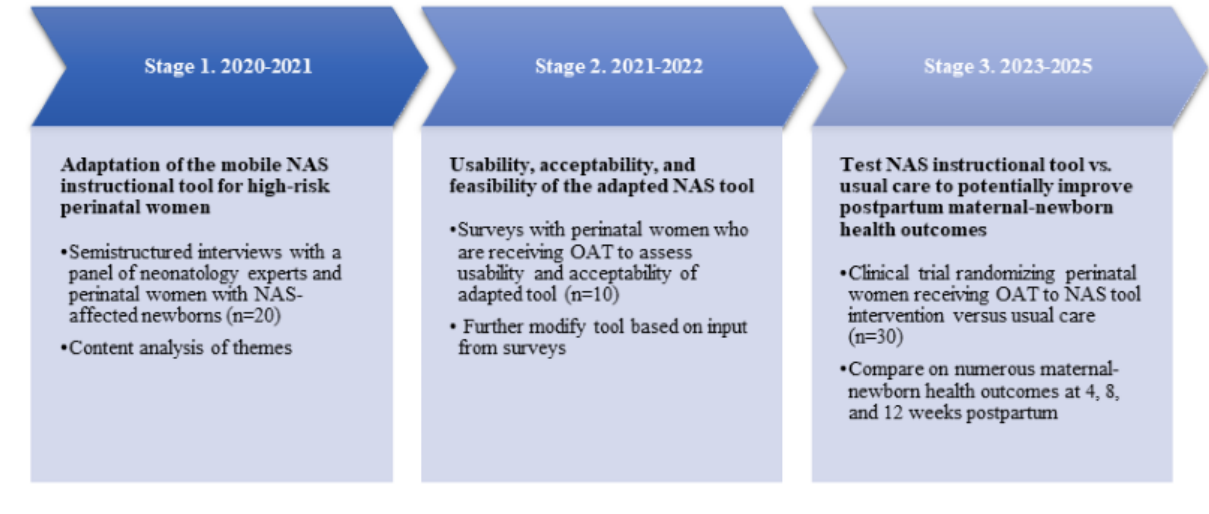
Figure 1. Stage process and time line of study. NAS: neonatal abstinence syndrome; OAT: opioid agonist